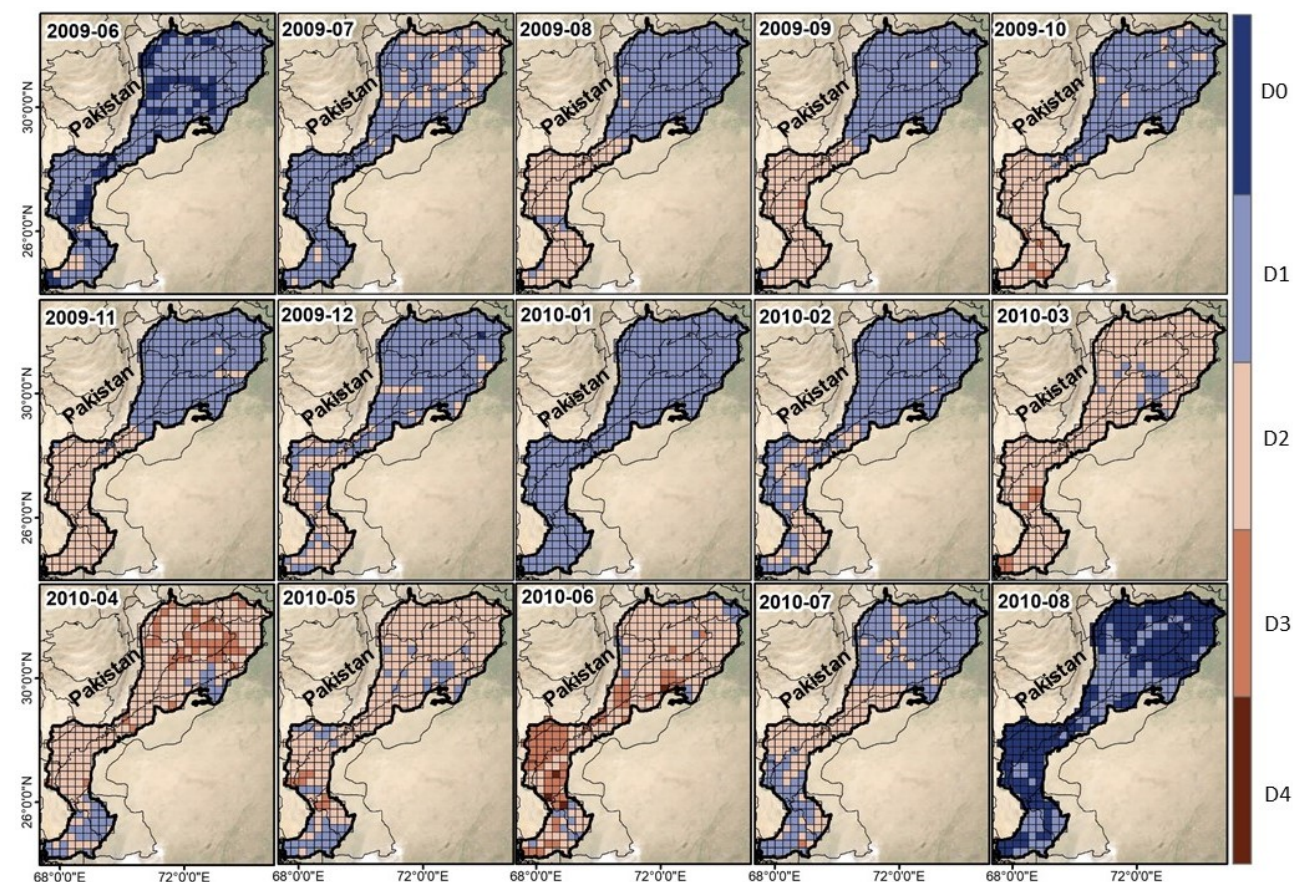
Figure 10. Drought events were captured from 2009.06 to 2010.08 at a spatial scale in IBIS.